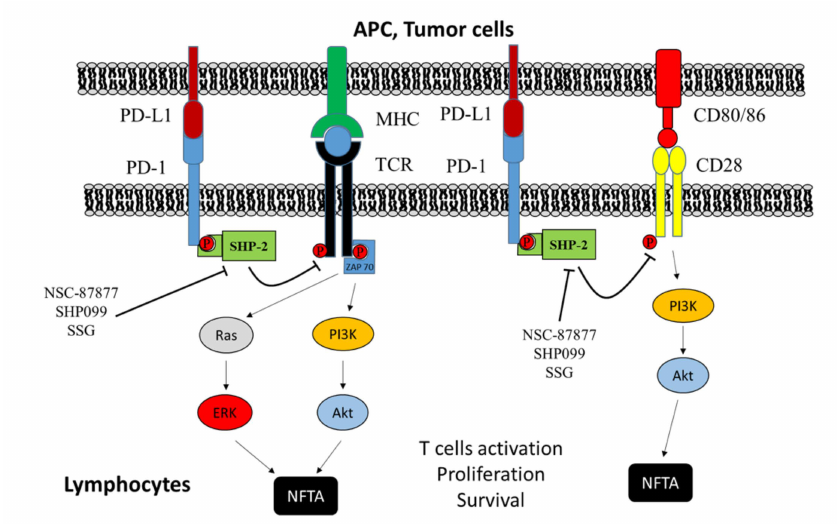
Figure 6. Targeting of SHP-2 in immune cells. After binding with PD-L1 ligand exposed by cancer cells or APC cells, PD-1 undergoes activation and recruits SHP-2, which can dephosphorylate ZAP70 or activate CD28 immune receptor. By this mechanism, SHP-2 inhibits signaling originated by TCR and CD28, thereby leading to a reduction in TCR-mediated interleukin-2 (IL-2) production and the impairment of T cell proliferation. Conversely, the treatment with SHP-2 inhibitors, such as NSC-87877, SHP099, and SSG, enhances lymphocyte activation and cytokine release, and stimulates lymphocyte proliferation, inducing melanoma cell